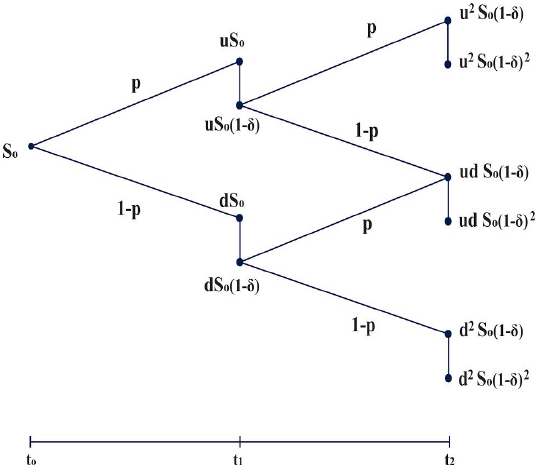
Figure 3. Two-period binomial asset pricing model with discrete